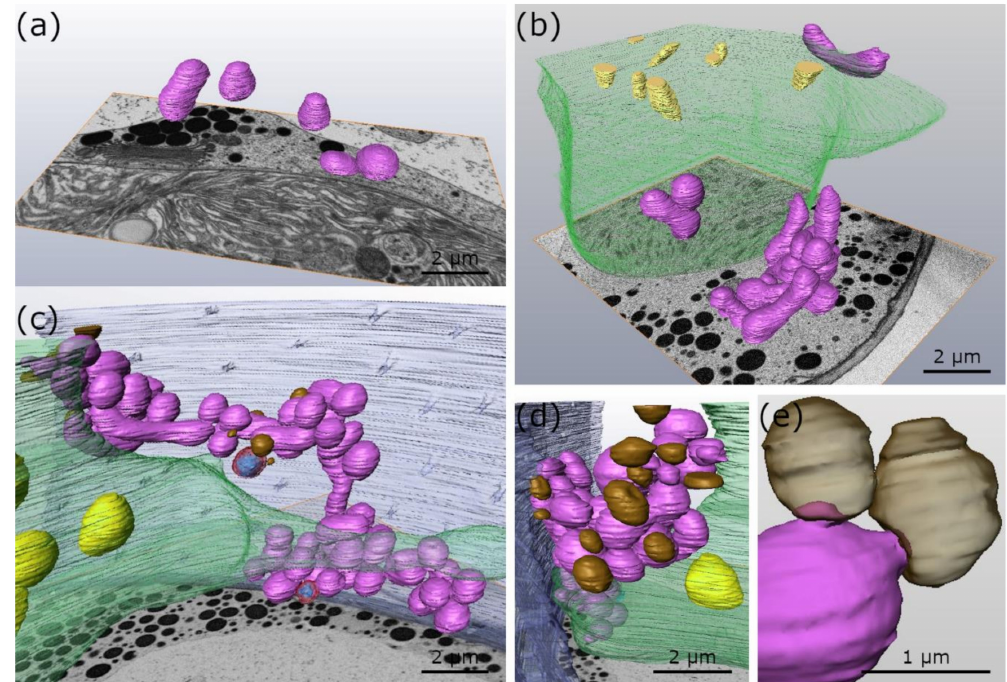
Figure 2. 3-D FIB-SEM reconstructions of organelles of Micrasterias denticulata during low temperature stress in comparison to controls at + 20 ◦ C. ( a ) Control at + 20 ◦ C with single unfused mitochondria ( b ) − 2 ◦ C freezing (without ice) treatment. Mitochondria aggregated and fused to single mitochondrial clusters. ( c ) − 2 ◦ C, extracellularly frozen cell, with large mitochondrial network. ( d ) − 2 ◦ C, extracellularly frozen cell, with mitochondrial network in contact with mucilage vesicles. ( e ) Higher magnification of − 2 ◦ C, extracellularly frozen cell depicts protrusion of mitochondria into transparent mucilage vesicles. purple: mitochondria, green: chloroplast, (transparent) brown: mucilage vesicles, transparent red with blue crystal: peroxisomes, yellow: starch grains, blue: cell wall with cell pores.